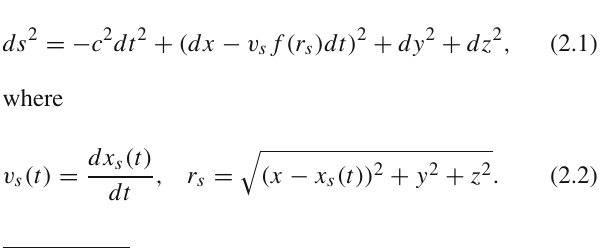
Here, the parameter r s refers to the distance between any spacetime point ( x , y , z ) and the center of the bubble. The function f should vanish at a large distance for the spacetime to be asymptotically flat, and becomes a unit at the center of the bubble for the bubble to travel at an apparent velocity v s .